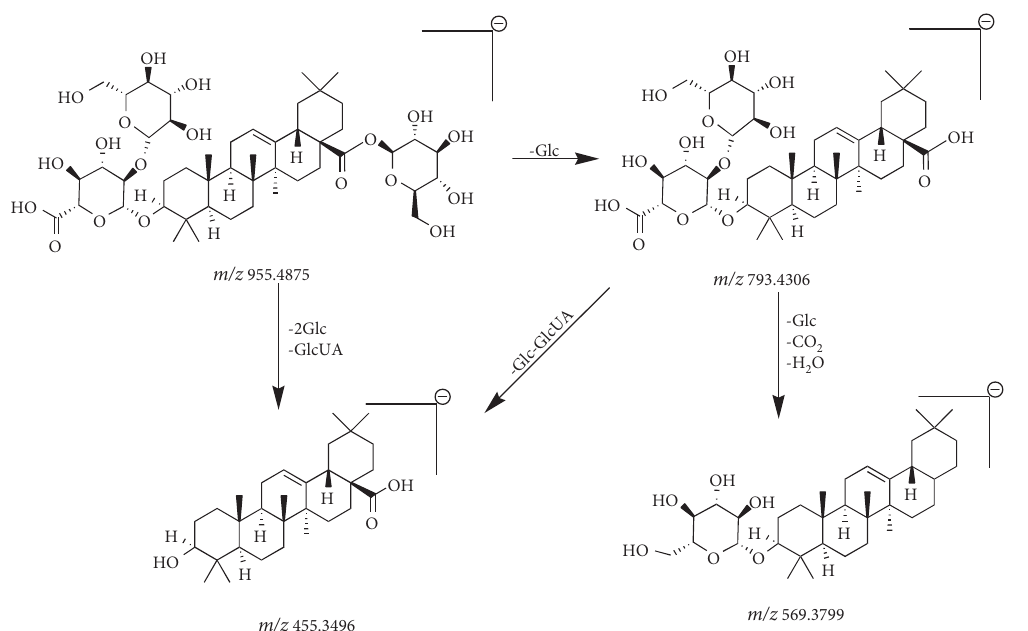
Figure 10: Secondary mass spectrogram of ginsenoside